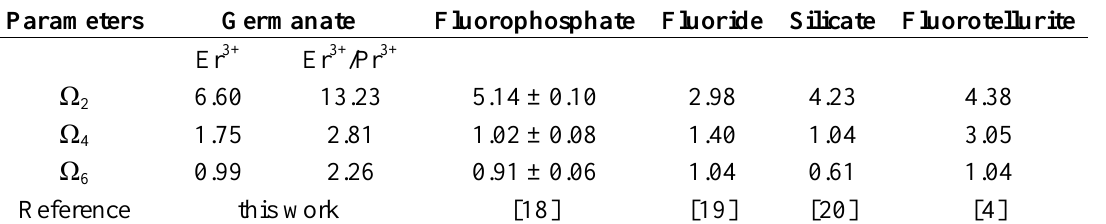
Table 1. Judd-Ofelt intensity parameters in various glasses (unit: 10 − 20 cm 2